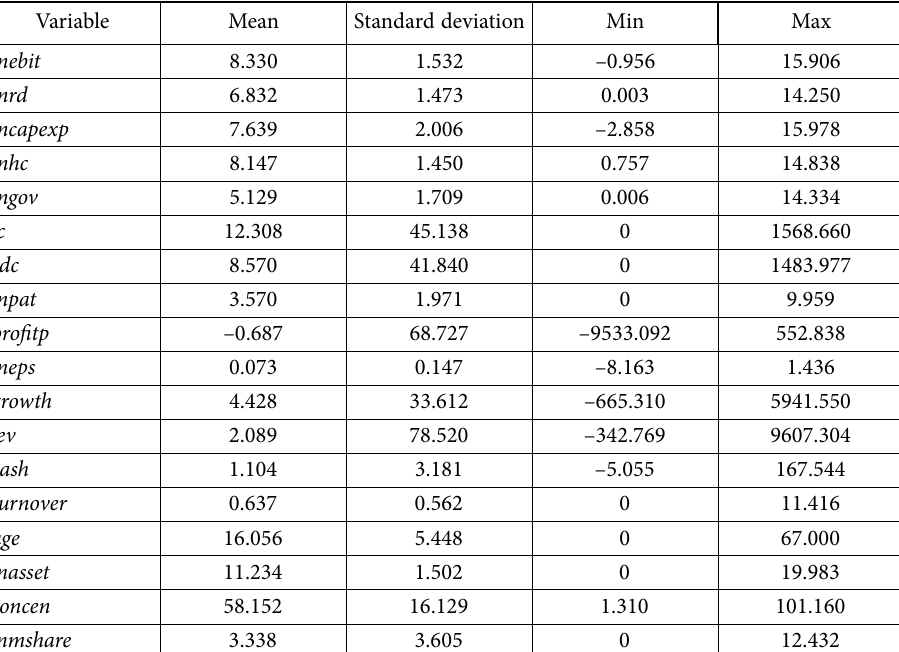
Table 1. Descriptive statistics of main variables (source: authors’ calculation)